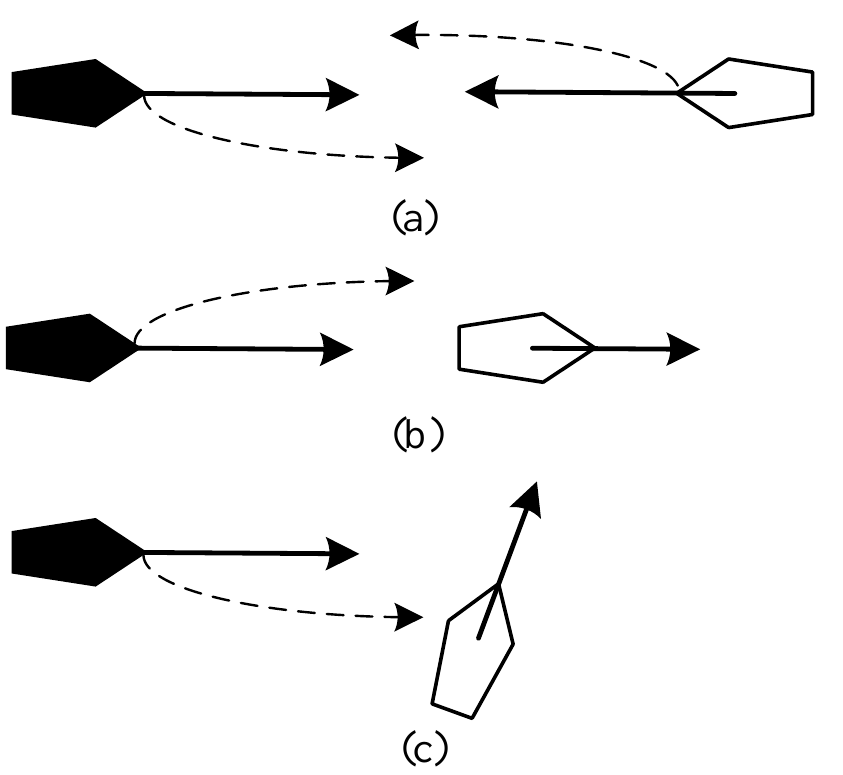
Figure 2. Inland-ship encounter situations: ( a ) head-on, ( b ) overtaking, and ( c ) crossing. In Figure 2, the two ships should pass on the port side in a head-on situation. In the overtaking situation, the overtaking ship is a give-way ship, and the overtaking ship should meet the overtaken ship on the starboard side. In the crossing situation, if there is a target ship coming from the starboard angle of 5° to 112.5°, the own ship is a give-way ship. Then, the own ship shall meet on the port side and pass the stern of the ship that has given way. If there is a ship from the port angle of 5° to 112.5°, the target ship shall be considered a give-way ship. It shall also meet the own ship on the port side and pass the stern of the own ship. The ship domain is the smallest water area where ships can navigate safely. If a target ship enters the ship domain, it will form a close-quarters situation. At this time, if necessary, both ships should actively avoid or even abandon the inland-river collision-avoidance regulations. Traditional ship domains include the Goodwin, Coldwell, Fujii [33], and Quaternion models [34]. Combining the above models with the inland-river environment, this paper designs the inland-ship domain shown in Figure 3.